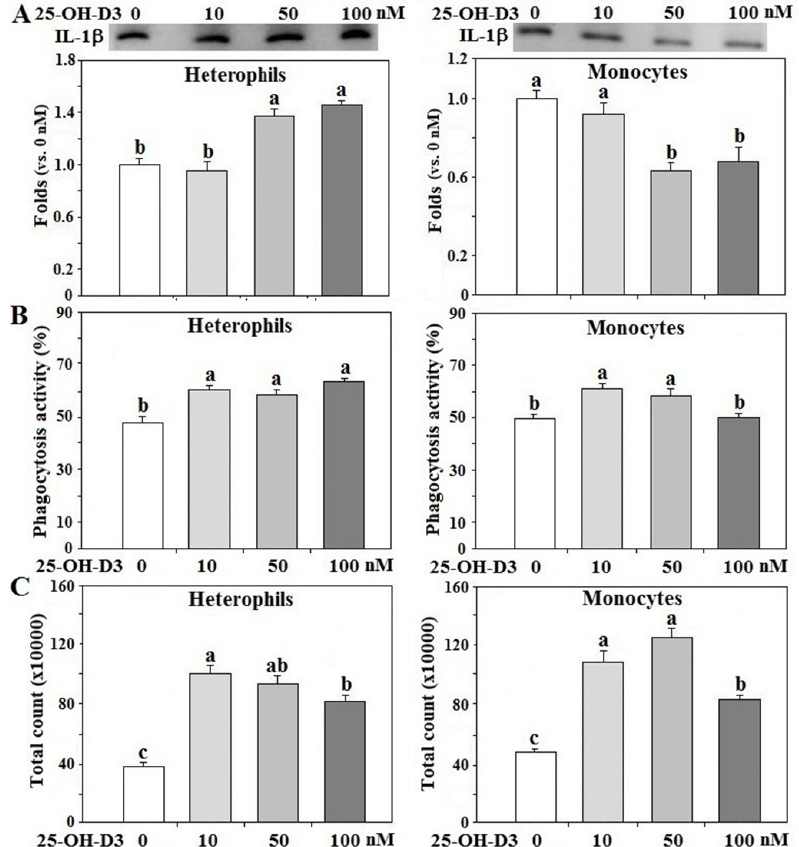
Figure 5. Effects of 25-OH-D 3 on leukocyte functions. Peripheral heterophils and monocytes (2 × 10 6 cells) isolated from R-hens at age 61–65 weeks were treated with various levels of 25-hydroxycho- lecalciferol (25-OH-D 3 ) overnight (16 h). Media were collected for interleukin-1 β (IL-1 β ) analysis by Western blot method based on protein equivalency ( A ); cells were collected for phagocytosis ( B ) and respiratory burst analysis ( C ) ( n = 4). Chemiluminescence results of respiratory burst analysis were expressed as integrated counts over 45 min. Results of Western blots were expressed as ratios relative to control (0 nM of 25-OH-D 3 ). Means with different letters differ significantly ( p < 0.05).